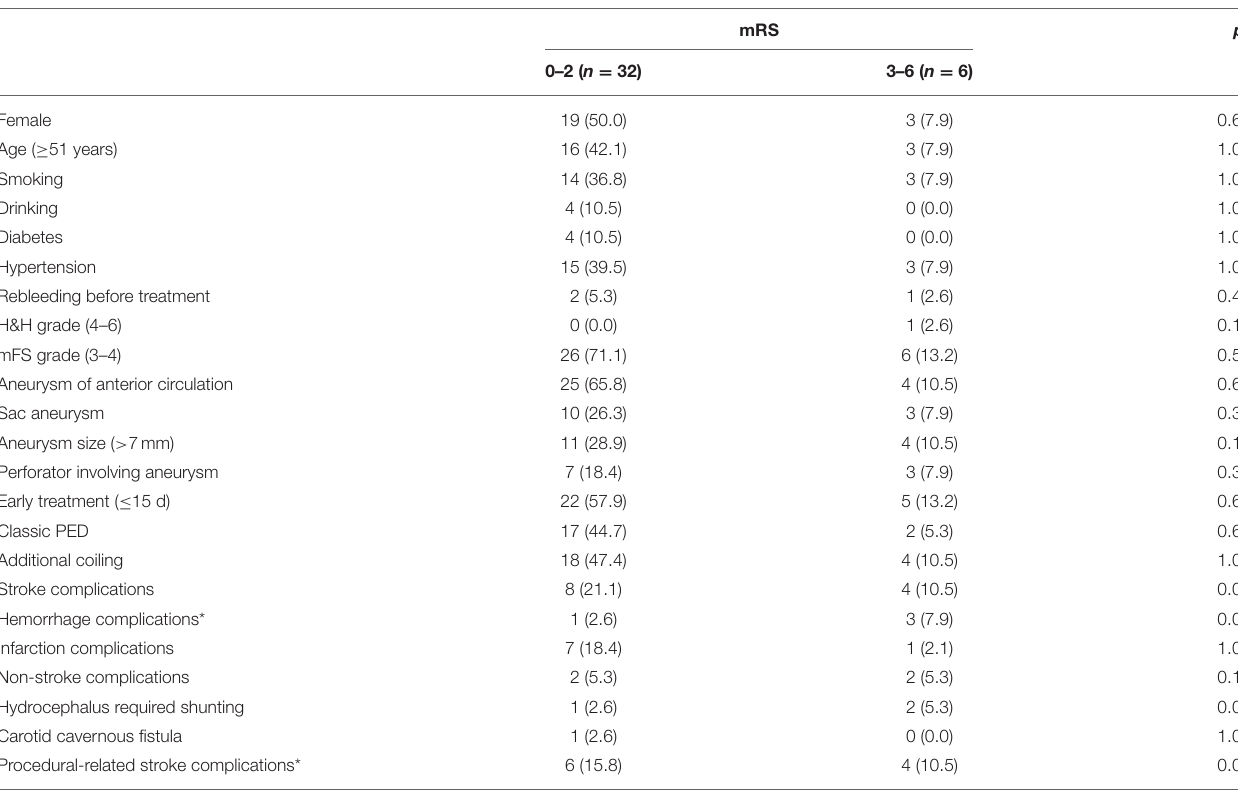
TABLE 2 | Factors associated with the clinical outcome.